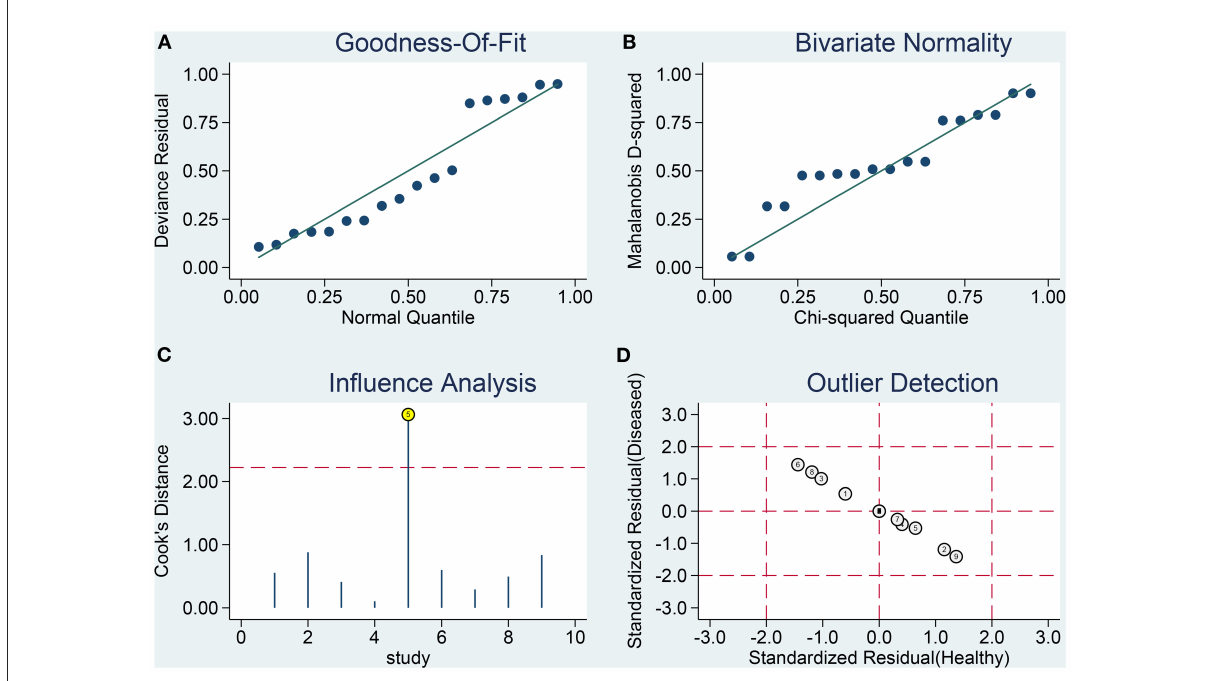
FIGURE4 Influence analysis and outlier detection. (A) goodness-of-fit, (B) bivariate normality, (C) influence analysis, and (D) outlier detection.